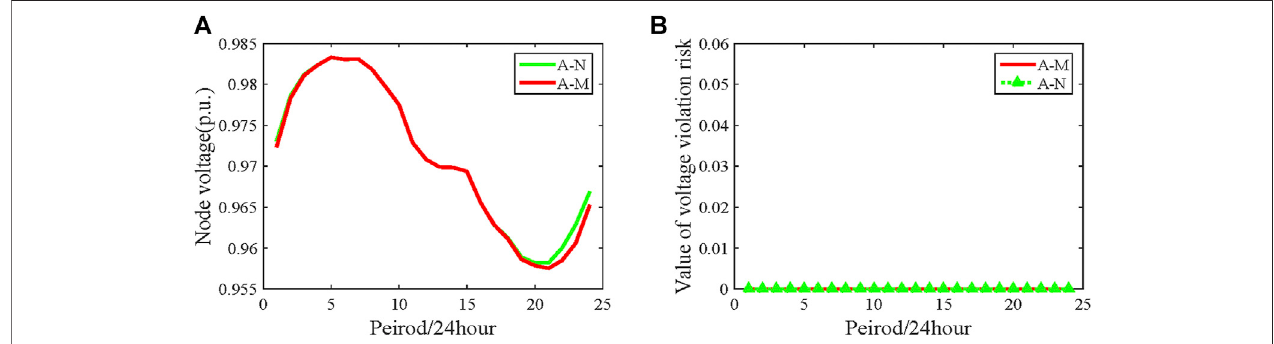
FIGURE 13 | Voltage analysis of node 13. (A) Voltage comparison of node 13 in the fi rst 24 h (1 st day). (B) Comparison of risk in the third 24 h (3 rd